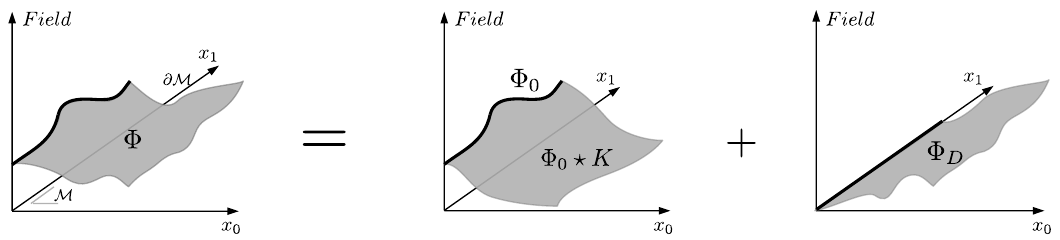
Figure 1 . The holographic decomposition of a quantum field Φ where Φ 0 is the boundary value of Φ , K is the boundary-to-bulk propagator, Φ is the Dirichlet component of Φ . Here, the field is D supported in M = R × R with boundary at x = 0 + 0